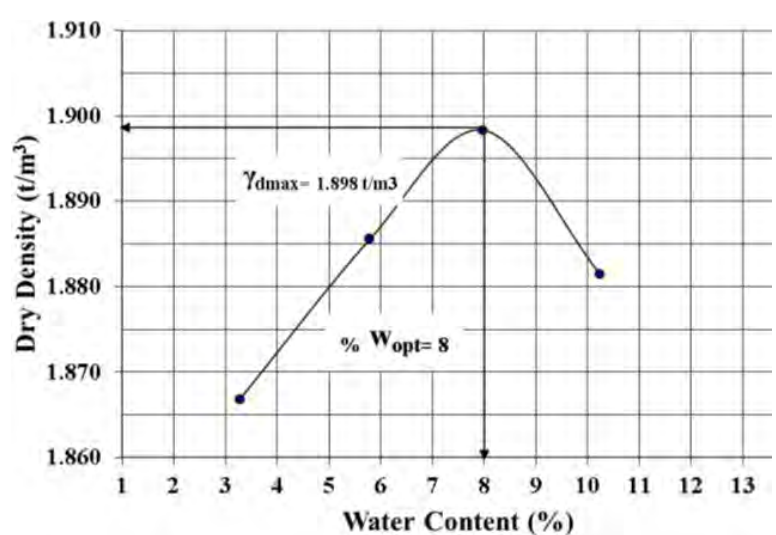
Figure 22. Modified proctor test for specimens from 89E km to 90.5E km at Serapum area